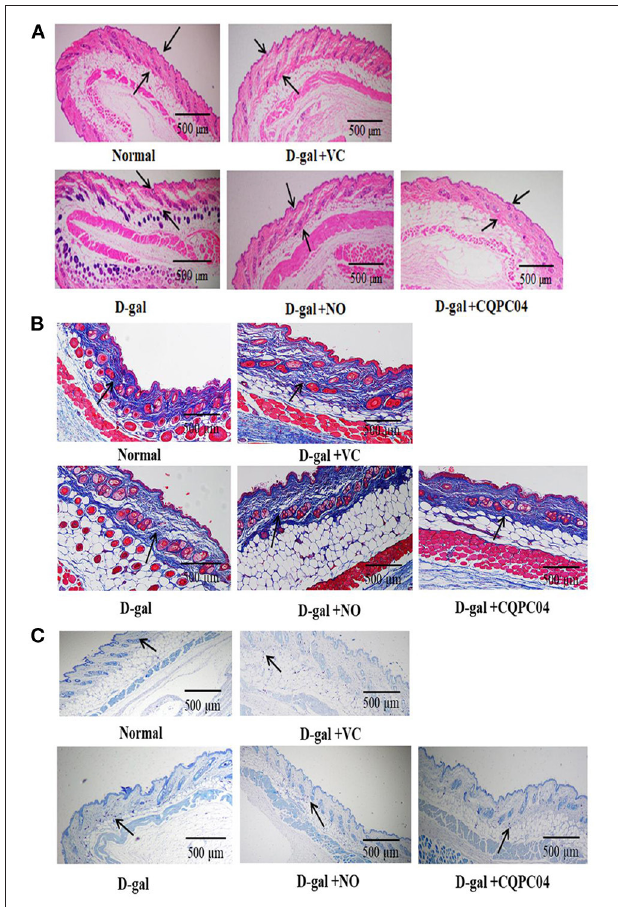
FIGURE 4 | Pathological observation of skin. (A) H&E stain of skin, the black arrows indicate corium layer, and the black bar represents 500 µ m; (B) Masson stain of skin, the black arrows indicate collagen fibers, and the black bar represents 500 µ m; (C) Toluidine blue stain of skin, the black arrows indicate mast cells, and the black bar represents 500 µ m. D-gal: mice fed the standard chow diet plus drinking water with intraperitoneal injection of D-galactose (120 mg/kg of BW); D-gal + VC: vitamin C (100 mg/kg of BW) plus intraperitoneal injection of D-galactose (120 mg/kg of BW); D-gal + NO: non-fermented soy milk (0.1 mL/10g of BW) plus intraperitoneal injection of D-galactose (120 mg/kg of BW); D-gal + CQPC04: L. fermentum CQPC04-fermented soy milk (0.1 mL/10g of BW) plus intraperitoneal injection of D-galactose (120 mg/kg of